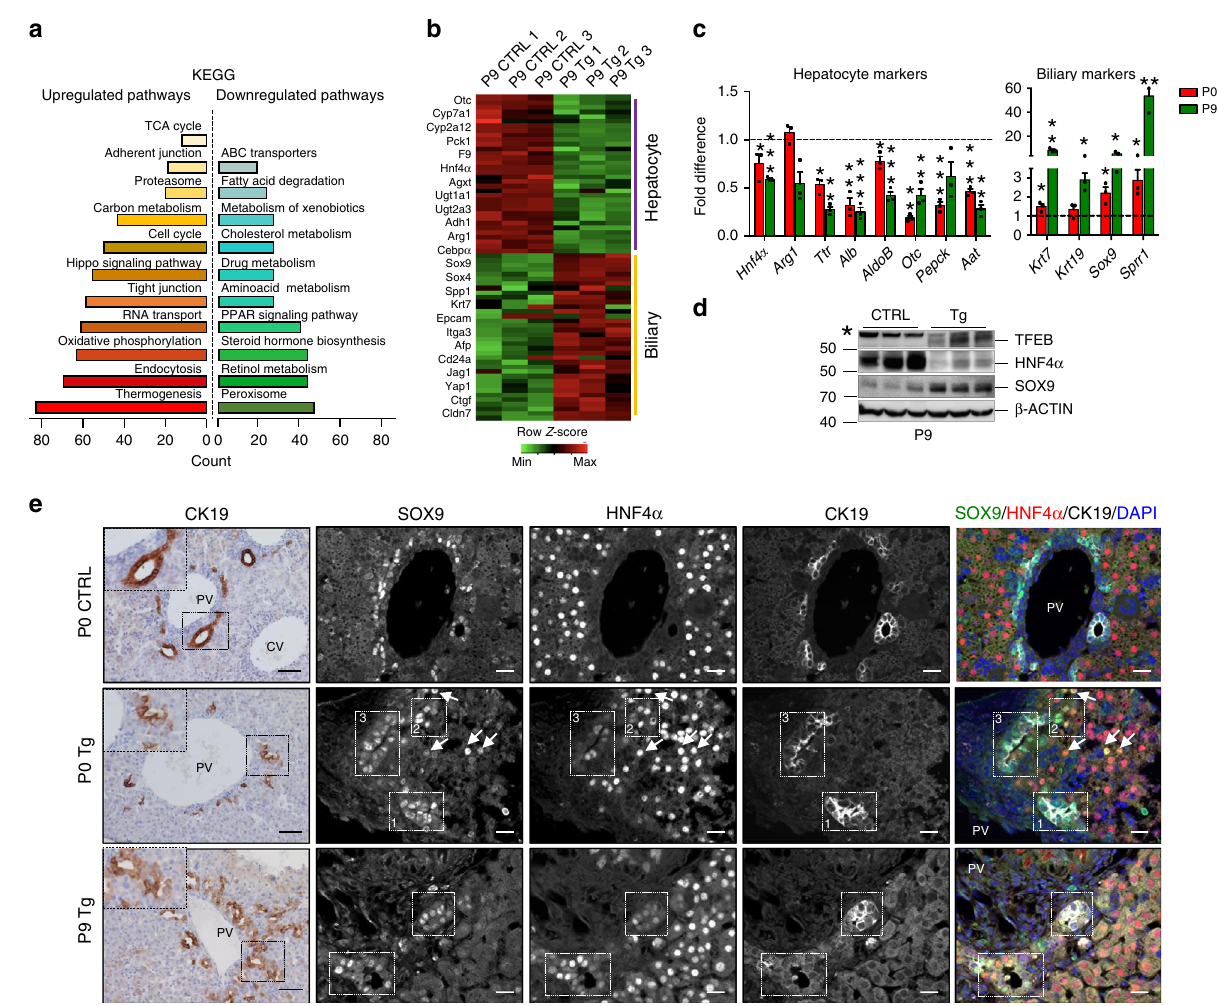
Fig. 3 TFEB overexpression inhibits hepatocyte differentiation in vivo. a KEGG pathways enriched in upregulated and downregulated genes of P9 liver overexpressing TFEB compared to CTRL. b Heat map showing the relative fold change of hepatocyte and biliary genes. c RT-PCR analysis of hepatocyte- and cholangiocyte-speci fi c markers in liver isolated from P0 and P9 mice ( n = 3 biological replicates). The dashed line represents gene expression levels in CTRL liver. Data are represented as mean ± SEM. * p ≤ 0.05, ** p ≤ 0.01 two-tailed Student ’ s t -test compared to age-matched CTRL. d Immunoblotting analysis of TFEB, HNF4 α , and SOX9 in liver extracts from mice at P9. Actin was used as a loading control. e Left panel: Representative images of liver sections from P0 and P9 mice stained for CK19. Scale bar 50 μ m. Right panels: triple immunostaining for HNF4 α (red), SOX9 (green), and CK19 (white) in liver sections from P0 and P9 mice of the indicated genotype showing the hybrid characteristics of hepatocytes and cholangiocytes in Tg mice. Note the cells expressing SOX9 and CK19 (box1), SOX9 and HNF4 α (box2) or SOX9/HNF4 α /CK19 (box3). Scale bar 20 μ m. Source data are provided as a Source Data fi